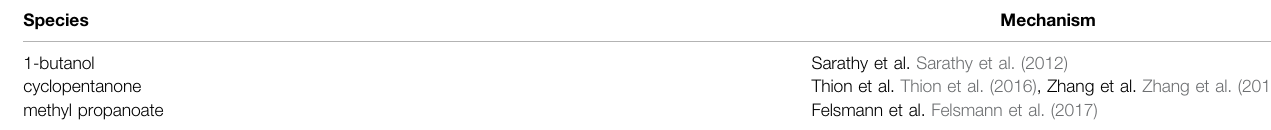
TABLE 1 | Chemical kinetics mechanisms used for ignition delay time simulations. Species